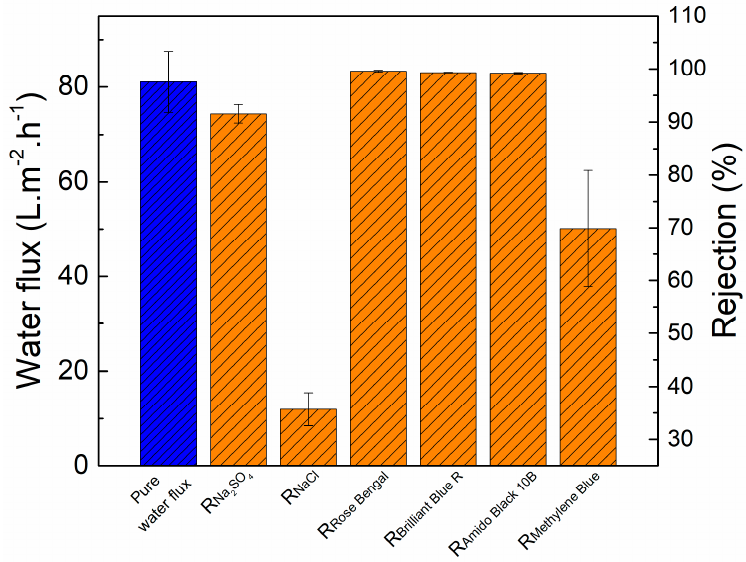
Figure 10. Separation performance of TFC-PEG20k. Feed = 1000 ppm aqueous salt solution or 50 ppm aqueous dye solution. Operating conditions = 0.60 MPa and 25 ° C.